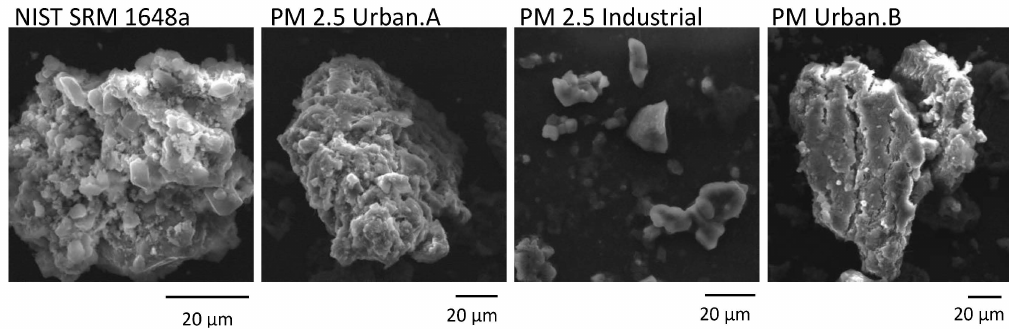
Figure 3. Comparison of PM collected in different locations in Krak ó